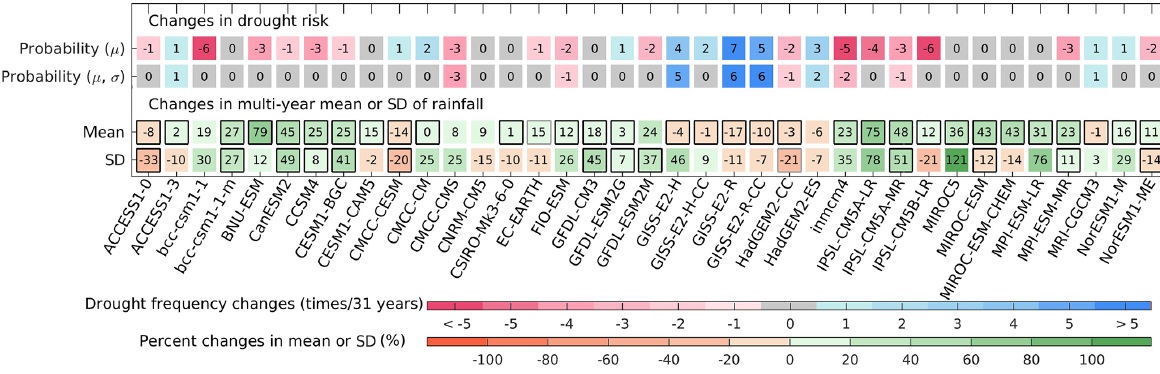
Figure 3. Rows 1 and 2 are changes in drought frequency (times per 31 years; top colour bar), for two methods of bias removal (mean- corrected only marked as “ µ ” and mean and SD corrected as “ µ , σ ”). This is for each of the 37 GCMs as labelled, and comparing the difference between the present period of 2001–2031 and period 2070–2100. GCM bias correction and 2016 ASO rainfall threshold are from the CHIRPS rainfall product. Rows 3 and 4 show the GCM-based changes in multi-year mean and SD of ASO rainfall respectively, and between the same periods as top rows (bottom colour bar). Black borders indicate statistically significant differences in the 31-year rainfall mean between these two periods (row 3, t test, with P < 0.05) and significant difference in SD of GCM projections (row 4, F test, with P < 0.05). Light grey borders in row 3 and row 4 indicate statistically significant difference at 5–10% significance level (0.05 ≤ P < 0.1). Values h(cid:16) (cid:17) i − 1 × x µ,σ /x µ,σ in the third and fourth rows are the percentage changes in 31-year mean and SD of rainfall as corr , 2070 − 2100 ,j corr , 2001 − 2031 ,j h(cid:16) (cid:17) i − 1 × 100%, respectively. Here overbar is time-averaging over period of σ µ,σ /σ µ,σ 100% and corr , 2070 − 2100 ,j corr , 2001 − 2031 ,j